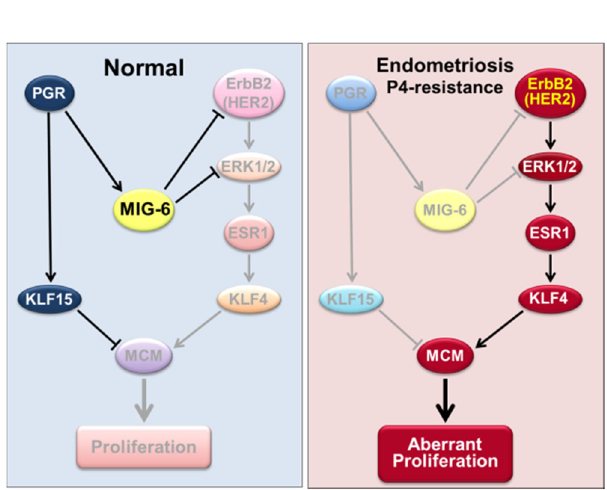
Fig. 8 Molecular mechanisms of MIG-6 function in the uterus. MIG-6 mediates P4 inhibition of E2 signaling by inhibiting ErbB2-ERK signaling (Left side), and the attenuation of MIG-6 leads to ErbB2-ERK activation, proliferation of uterine epithelial cells, and eventually to endometriosis and infertility (Right